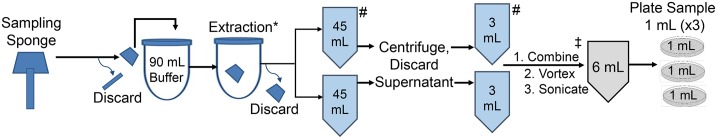
Pictorial overview of the sample process and analysis method for each sampling sponge.*For sponges used with the multi-medium multi-pass composite (MM-MPC) method, each of the sponges used for sampling were extracted one at a time, in the same 90 mL buffer. #The volume following extraction was >90 mL (up to 105 mL) for MM-MPC samples; therefore, the sample was split into three aliquots prior to being combined. ‡The final target volume for all methods was 6 mL, including the MM-MPC method.